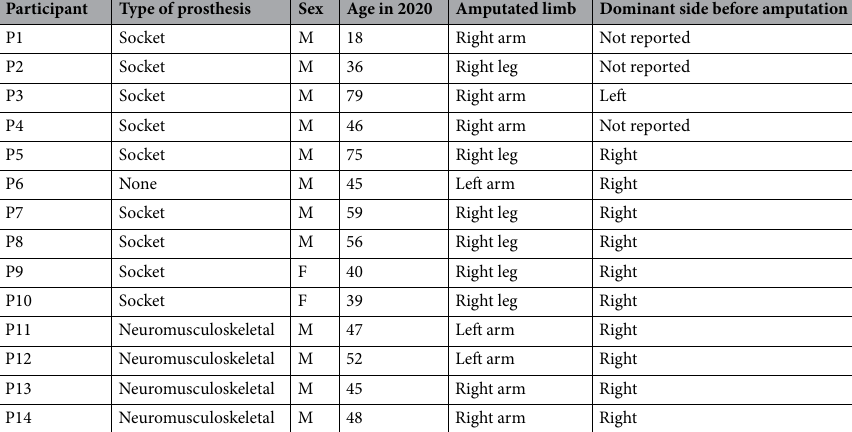
Table 1. Participant